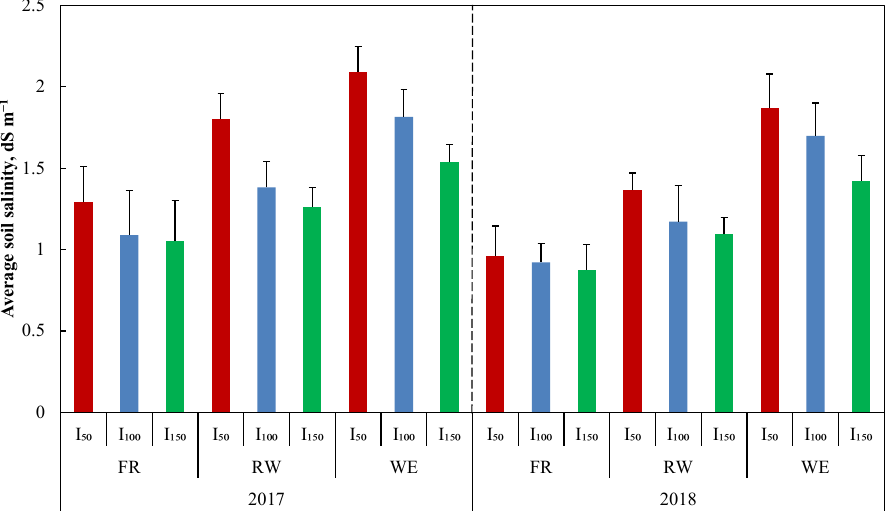
Figure 5. Salinity in the soil layers (0–100 cm deep) at three irrigation levels (I 50 , I 100 , and I 150 : 50%, 100%, and 150% of crop evapotranspiration, respectively) across three water qualities (FR: freshwater, RW: reclaimed wastewater, and WE: well-water) measured at three dates in both experimental years. Bars represent mean values ± standard error of triplicate measurements.